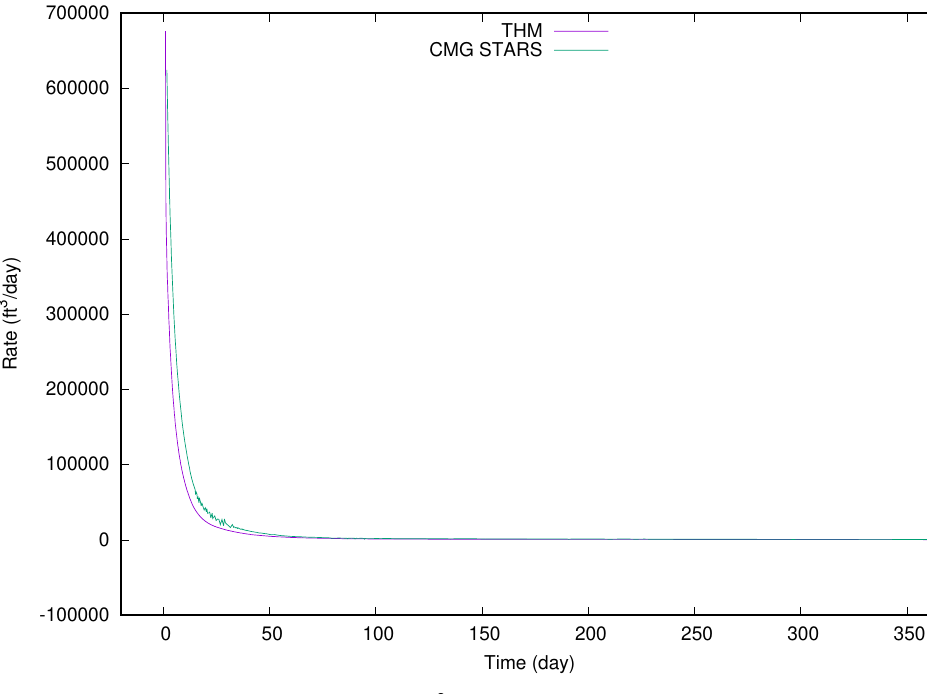
Figure 14. Example 2: gas production rate (ft 3 /day), first production